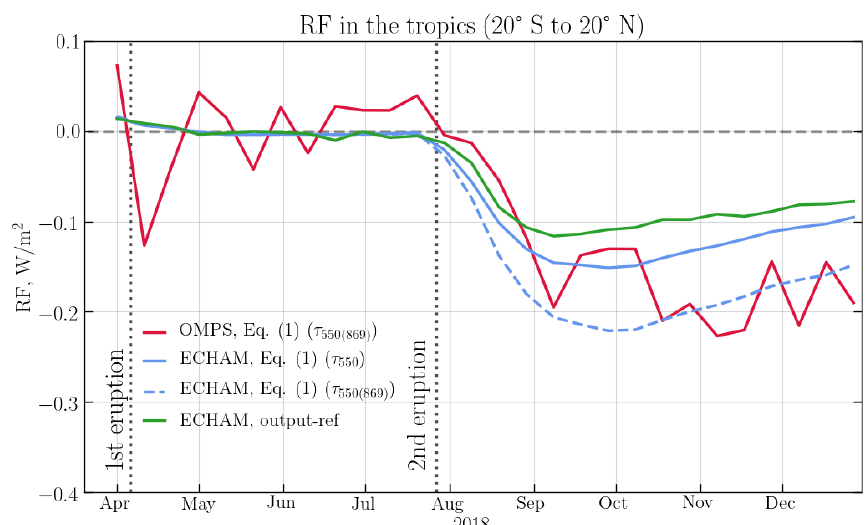
Figure 6. The radiative forcing (RF) from ECHAM and OMPS-LP averaged over the Tropics (20 ◦ S–20 ◦ N). The green line shows the difference between ECHAM instantaneous RF calculated accounting for and neglecting the Ambae eruptions. Red and blue lines show, respectively, the RF calculated with Eq. (1) from OMPS-LP τ 869 converted to τ 550 ( 869 ) , and ECHAM τ 550 (blue solid) and ECHAM τ 869 converted to τ 550 ( 869 ) (blue dashed). From all data sets, the respective mean RF in the period from the 1 April to the 19 July 2018 was